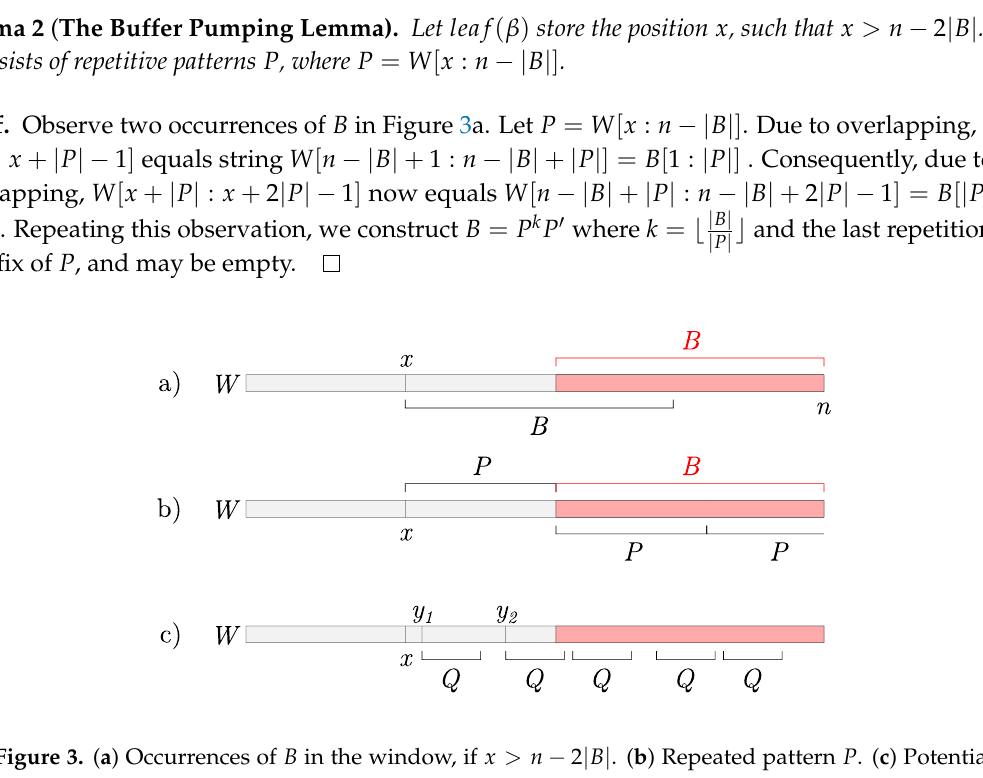
Figure 3. ( a ) Occurrences of B in the window, if x > n − 2 | B | . ( b ) Repeated pattern P . ( c )